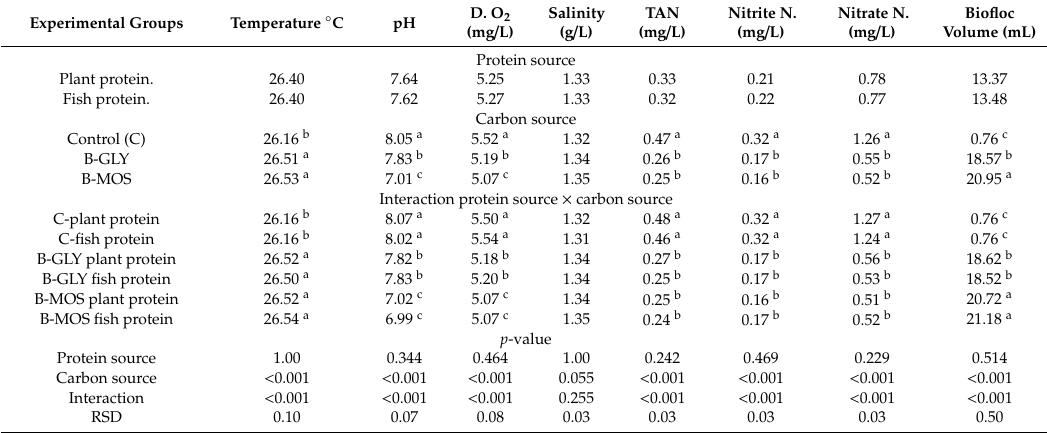
Table 3. The e ff ect of di ff erent dietary protein sources and carbon sources on Nile tilapia (O. niloticus) water quality parameters.